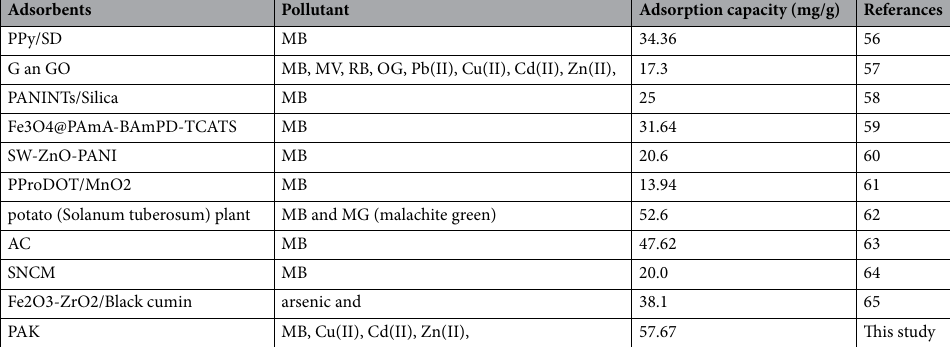
Table 3. The maximum adsorption capacities of PKA and other adsorbents for